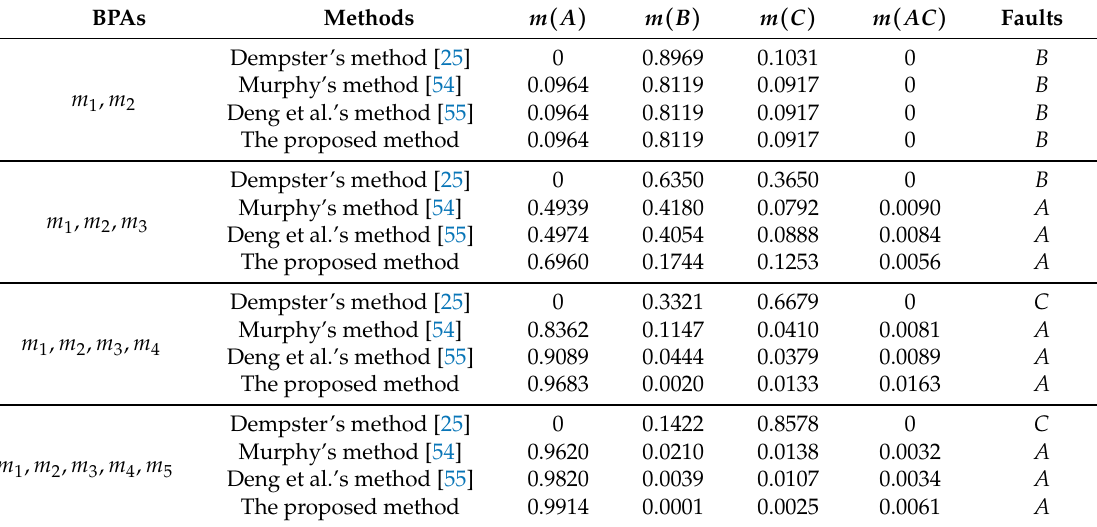
Table 2. Comparison of several existing methods.